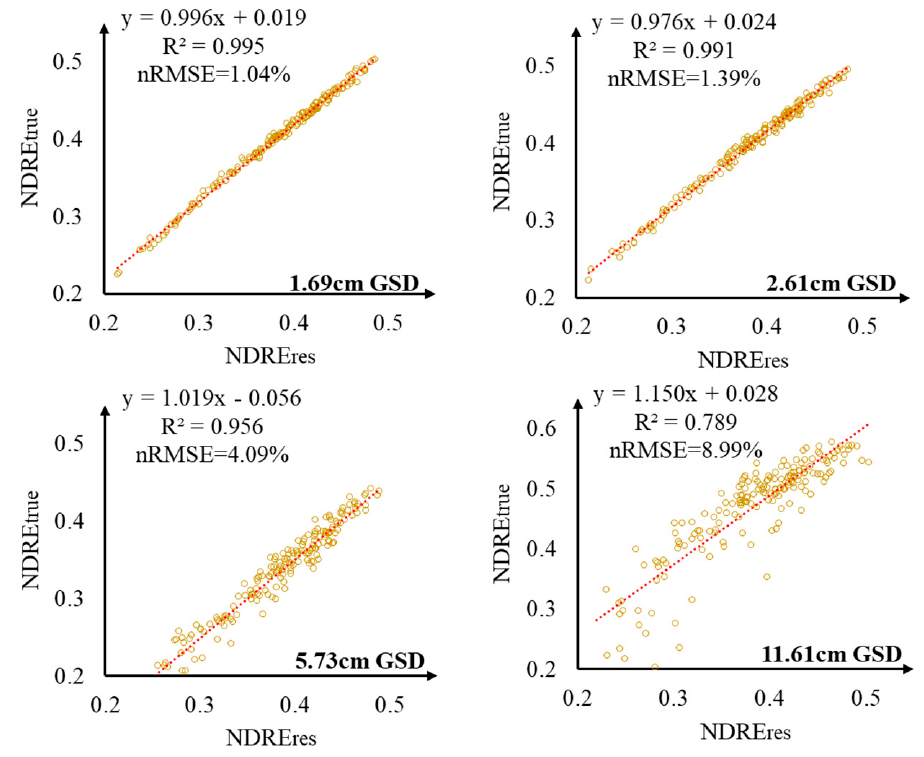
Figure 6. Scatter plots and regression lines of NDRE from in situ UAV image (NDREtrue) versus NDRE from resampled images (NDREres) at different GSDs.